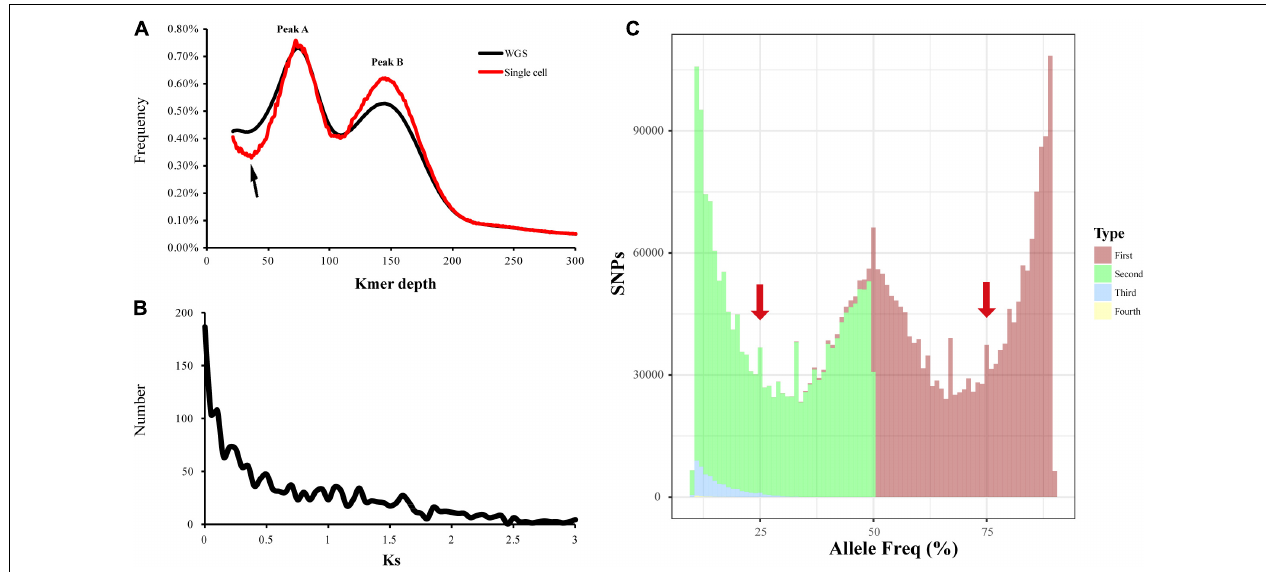
FIGURE 3 | Evaluation of genome duplication of L. vannamei . (A) K-mer distribution of the single sperm cell and whole-genome sequencing (WGS) data. (B) Ks frequency distribution for pairs of paralogous genes in the Litopenaeus vannamei genome. (C) Allele frequency spectra based on read counts of single-nucleotide polymorphisms (SNPs). For each SNP site, the appearance frequencies of the four bases were sorted from most (Type: First) to least (Type: Fourth). Leftmost and rightmost truncated peaks likely correspond to variations between individuals in a population. For polyploidy genome, the peaks at 25, 50, and 75% would be expected.